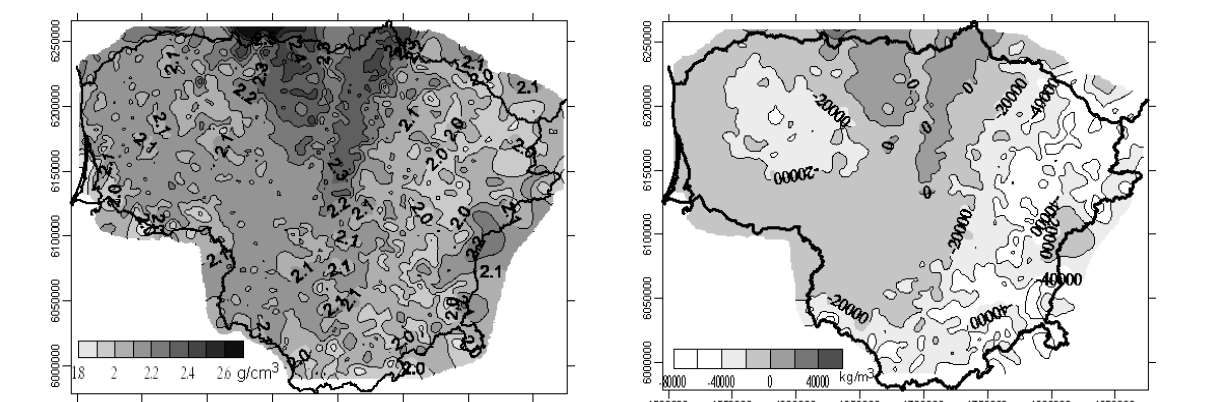
Fig 3. Locations of wells employed for calculation of topography densities (13 222 wells)